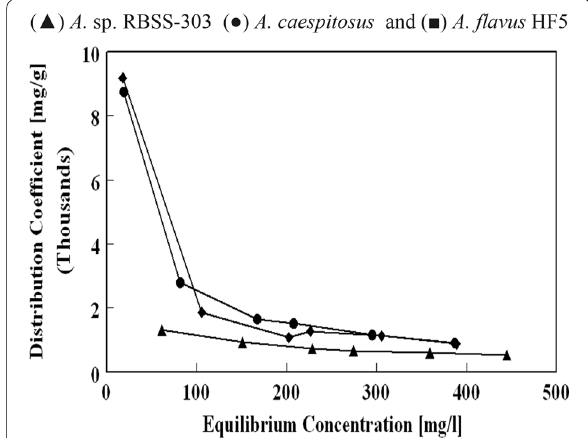
Fig. 4 Distribution coefficient for Pb(II) biosorption by A. sp. RBSS- 303, A. caespitosus and A. flavus HF5 (0.05 g dry weight/100 mL of Pb(II) solutions of various concentrations incubated for 6 h at 180 rpm and 28 2 ±